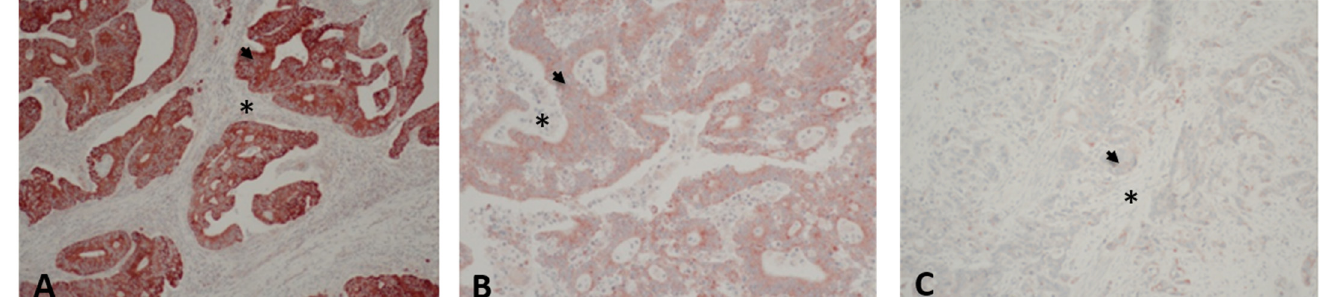
Figure 1. Representative images of DDR1 immunolabeling in colon adenocarcinoma. A. Strong and diffuse staining (red) in adenocarcinoma cells (arrow), (magnification × 10), scored 3+/high; B. Moderate and diffuse staining (red) in adenocarcinoma cells (arrow), (magnification × 20), scored 2+/high; C. Faint staining (red) in adenocarcinoma cells (arrow), (magnification × 10), scored 1+/low. Stromal cell highlighted by an asterisk (*) was weak ( A ) or negatively ( B , C ) stained in all cases. RNA from tumor and stromal microdissected tissues were isolated and purified as indicated